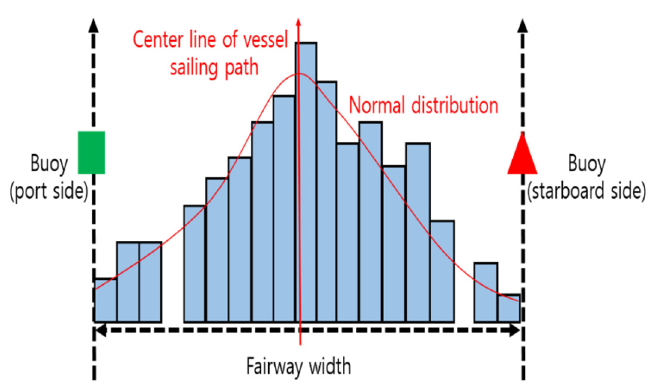
Figure 3. Vessel sailing path with normal distribution.